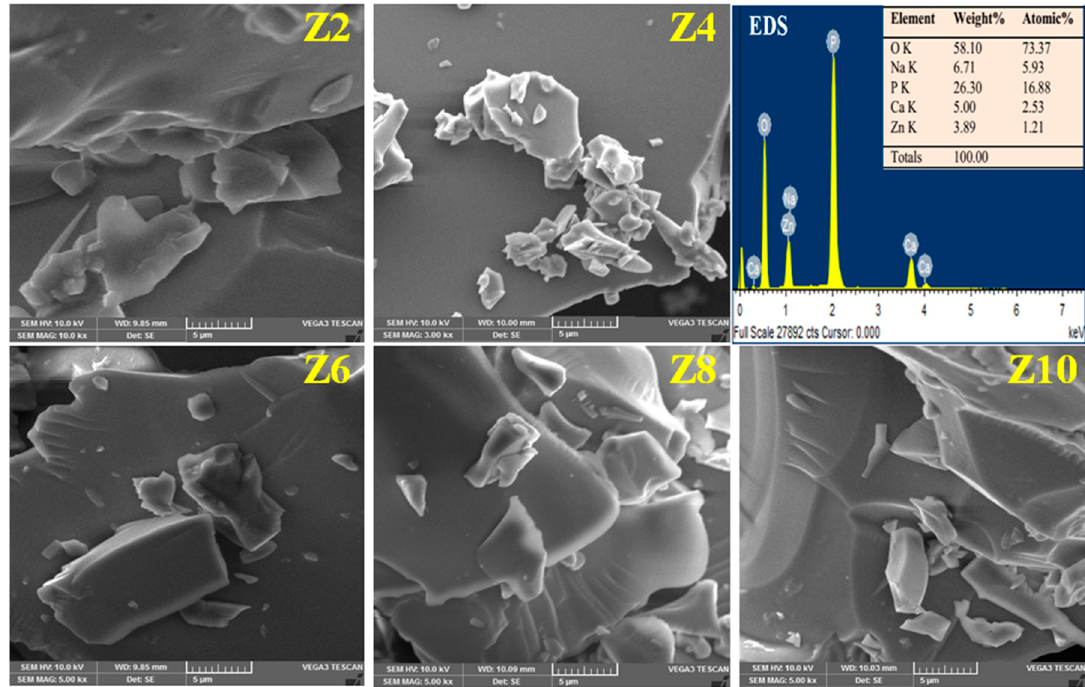
Figure 5. SEM micrographs and EDS spectra of ZnO doped phosphate bioglass samples.